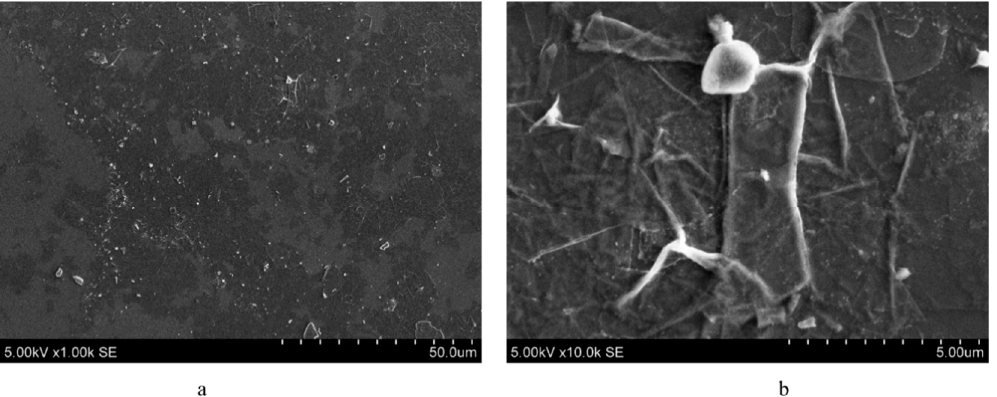
Figure 1. Scanning electron microscope analysis of MXene: ( a ) partially delaminated scattered MXene flakes; ( b ) single MXene flake.